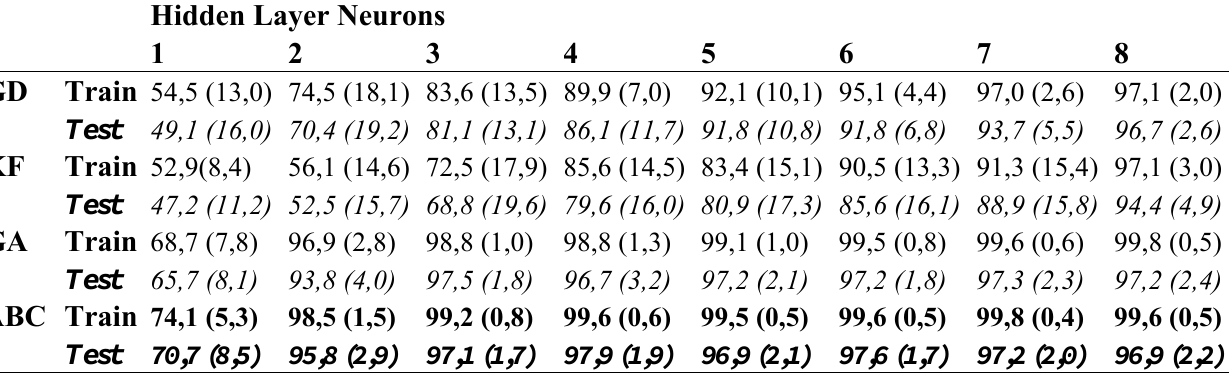
Table 5. Statistical PCCS results of Wine dataset.